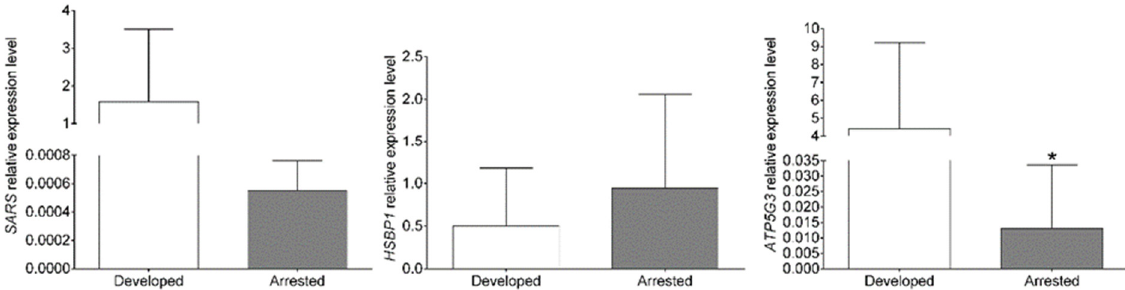
Figure 6. Confirmatory gene expression analysis with qPCR. Statistical analysis by unpaired t -tests with Welch’s correction, where * p -value < 0.05. Data plotted as means ± SDs, n = 4.